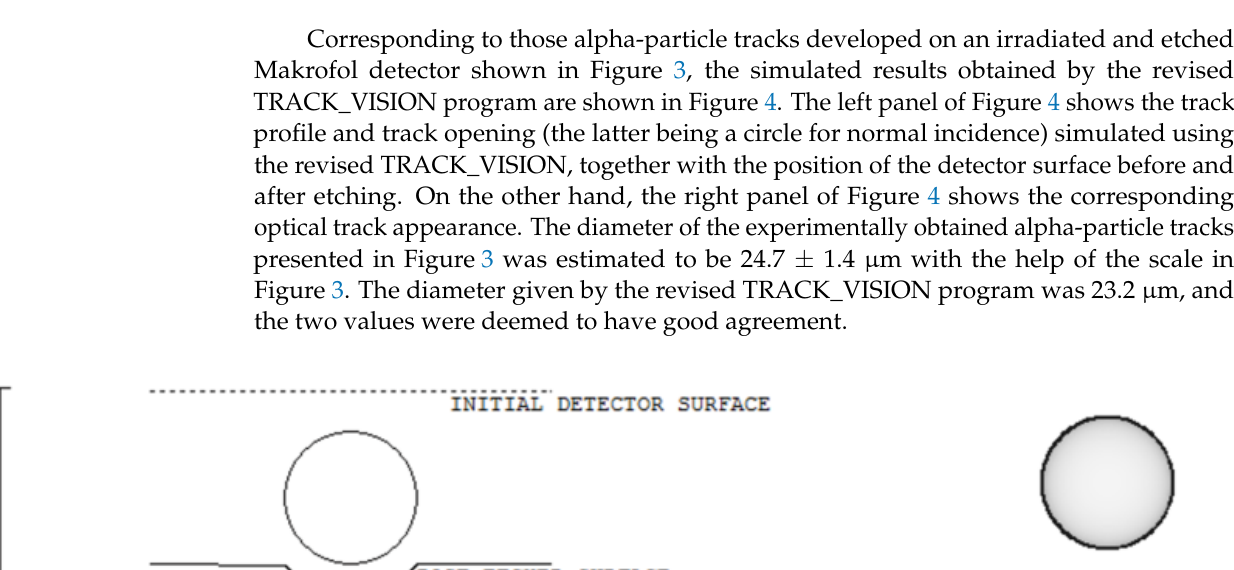
Figure 3. Alpha-particle tracks developed on an irradiated and etched Makrofol detector captured using an optical microscope. The detector was irradiated with alpha particles with an energy of 3.6 MeV under normal incidence and was then etched for 2 h. The removed detector thickness was determined as 30 ± 2 μ m. White scale bar: 26 µ m.